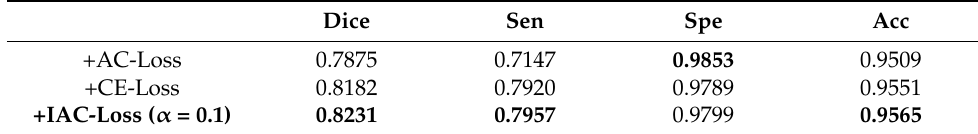
Table 6. Comparison of IAC-Loss with related loss function metrics.